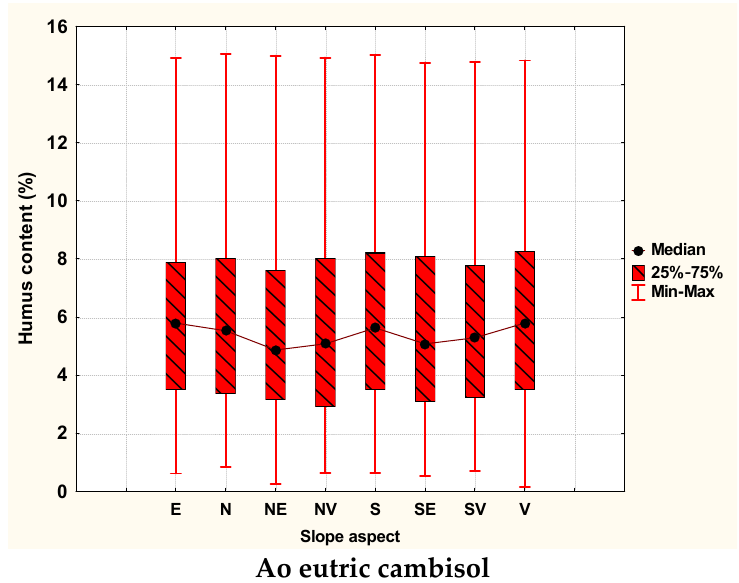
Figure 4. The variation of soil organic matter content in Ao horizon of eutric cambisol.